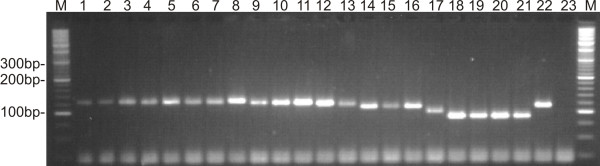
SSR allele frequency among 21 Physcomitrella patens accesssions and two related Funariaceae. One exemplary SSR marker was amplified in 21 Physcomitrella patens accessions (1, Gransden; 2, NeneWashes; 3, Cholsey; 4, Gemuend-K1; 5, Gemuend-K5; 6, Honnef; 7, Ukraine; 8, Trondheim; 9, Kaskaskia; 10, DelValleLake; 11, Villersexel-K3; 12, Villersexel-K4; 13, Uppsala; 14, Heimerbruehl; 15, Nennig; 16, Martinshof; 17, Bisoke; 18, Okayama; 19, Kumamoto; 20, Saitama; 21, Victoria;) and two related Funariaceae, Physcomitrium sphaericum (22) and Funaria hygrometrica (23). The SSR marker reveals at least six distinct alleles. Single alleles were found in the plants 1 – 13, 14 – 16, 17, 18 – 21, 22 and 23 respectively. Among the plants 1 – 13 potentially more alleles are present with only small size differences. DNA size markers (M) are a combination of a 100 bp and a 20 bp ladder (SIGMA-Aldrich).